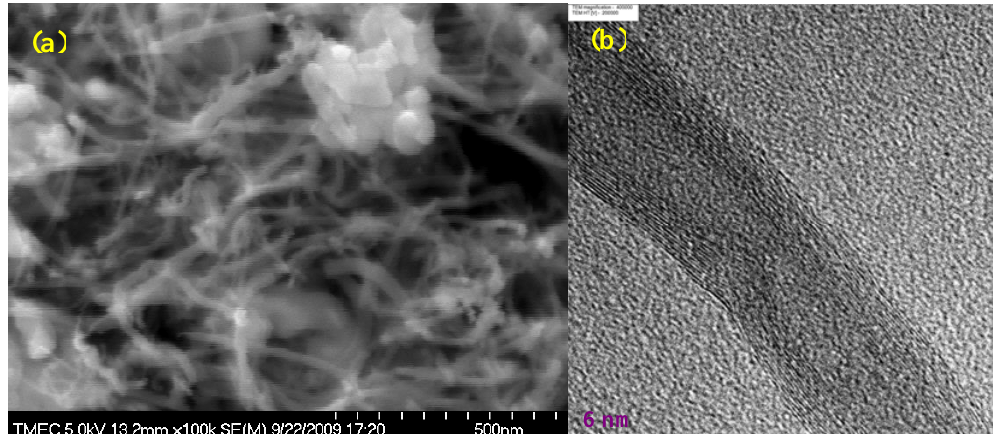
Figure 3. High magnification (a) top view SEM image of CNT electrodes after electrochemical polyaniline-enzyme coating and (b) TEM image of CNT extracted from the synthesized vertically aligned